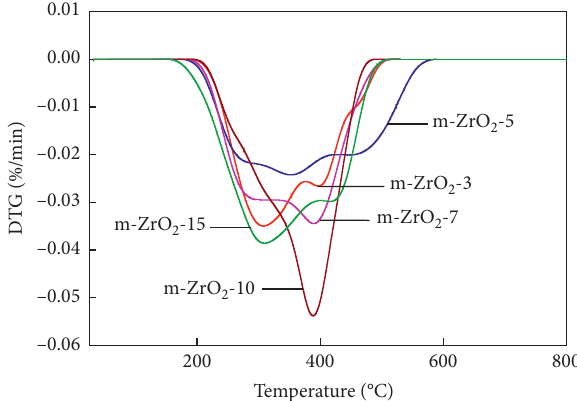
Figure 2: DTG diagrams of modified ZrO Table 2: Maximum degradation temperature and grafting efficiency of MSPMS to ZrO